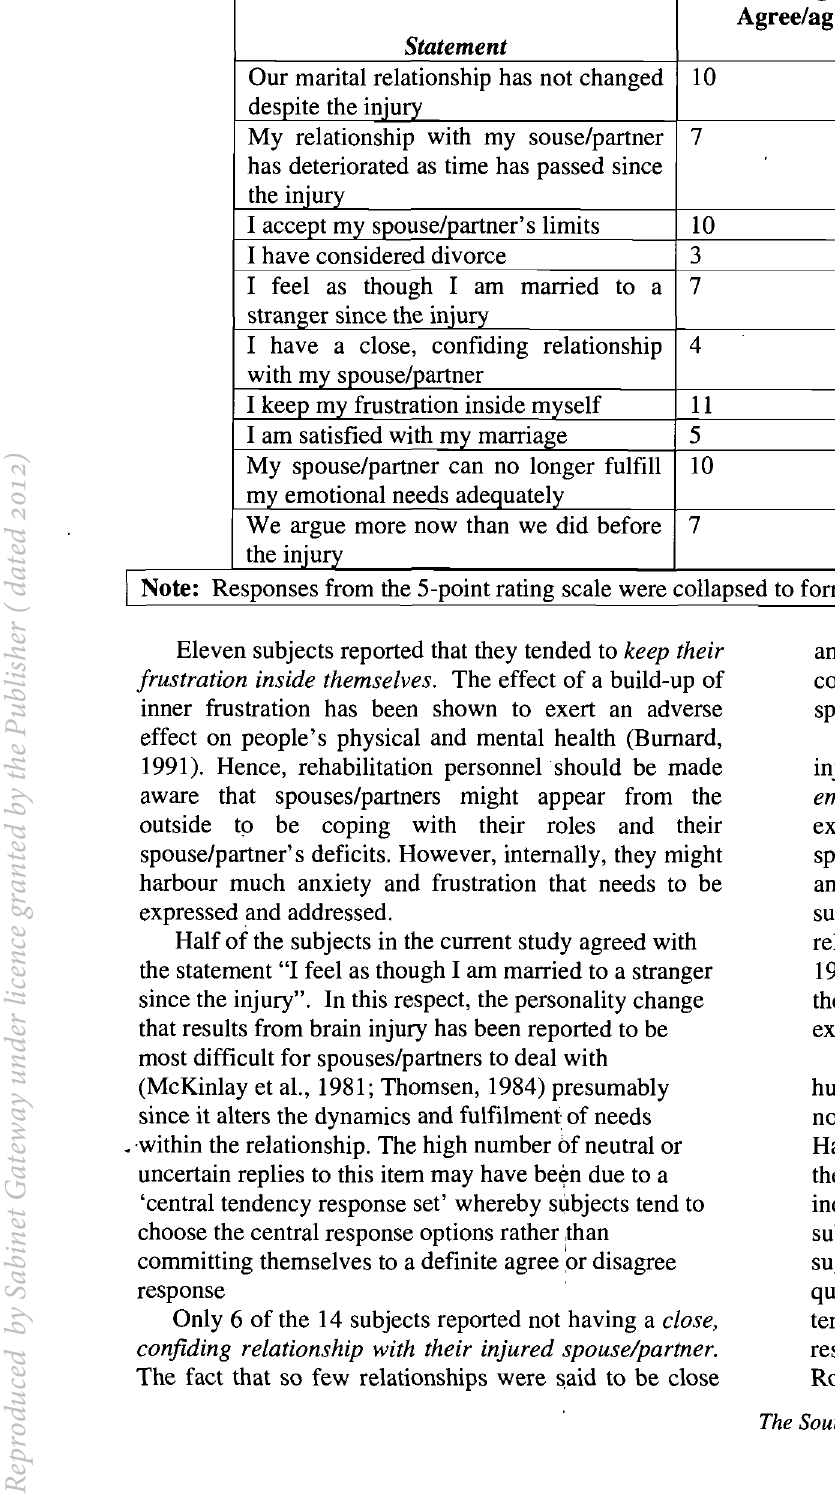
Strongly Disagree/